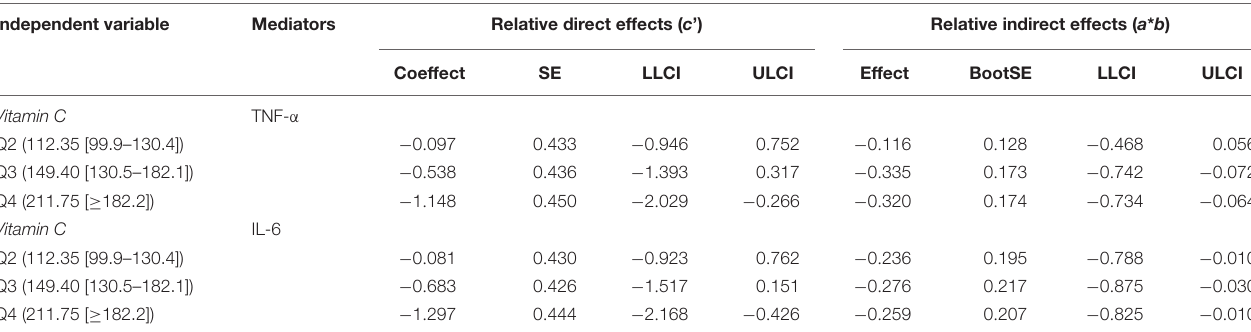
FIGURE 5 | The mediated pathways between Vitamin C and TCFA. (A) Mediating effect model: Vitamin C-TNF α -TCFA; (B) Mediating effect model: Vitamin C-IL6-TCFA; Considering that the independent variable vitamin C as a multi-category variable divided by quartiles of continuous data, we sequentially coded the independent variable vitamin C and analyzed the mediating effect of the category variable with the minimum intake as reference. TNF- α , tumor necrosis factor- α ; IL-6, interleukin-6; TCFA, thin cap fibroatheroma; Q, quartile. TABLE 5 | Effect of Vitamin C on TCFA mediated by TNF- α and